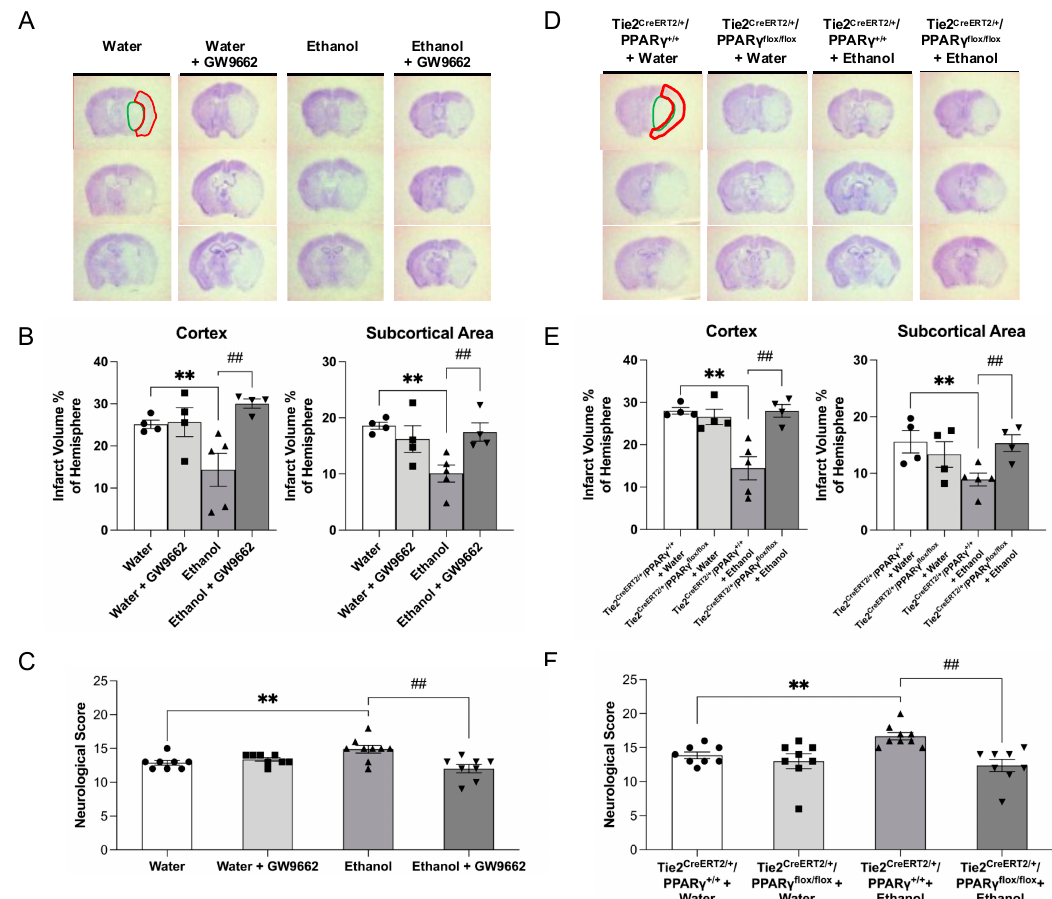
Figure 2. Effect of chronic ethanol consumption on cerebral I/R injury in the presence and absence of GW9662 and endothelial-specific conditional PPAR γ knockout. ( A , D ) Representative brain sections stained with cresyl violet. ( B , E ) Infarct volume in the cerebral cortex and subcortical area. ( C , F ) Neurological deficit score. Values are means ± SE. ** p < 0.05 vs. Water or Tie2 CreERT2/+ /PPAR γ +/+ + Water. ## p < 0.05 vs. Ethanol or Tie2 CreERT2/+ /PPAR γ +/+ + Ethanol. Analyzed using two-way ANOVA with Tukey’s post hoc.